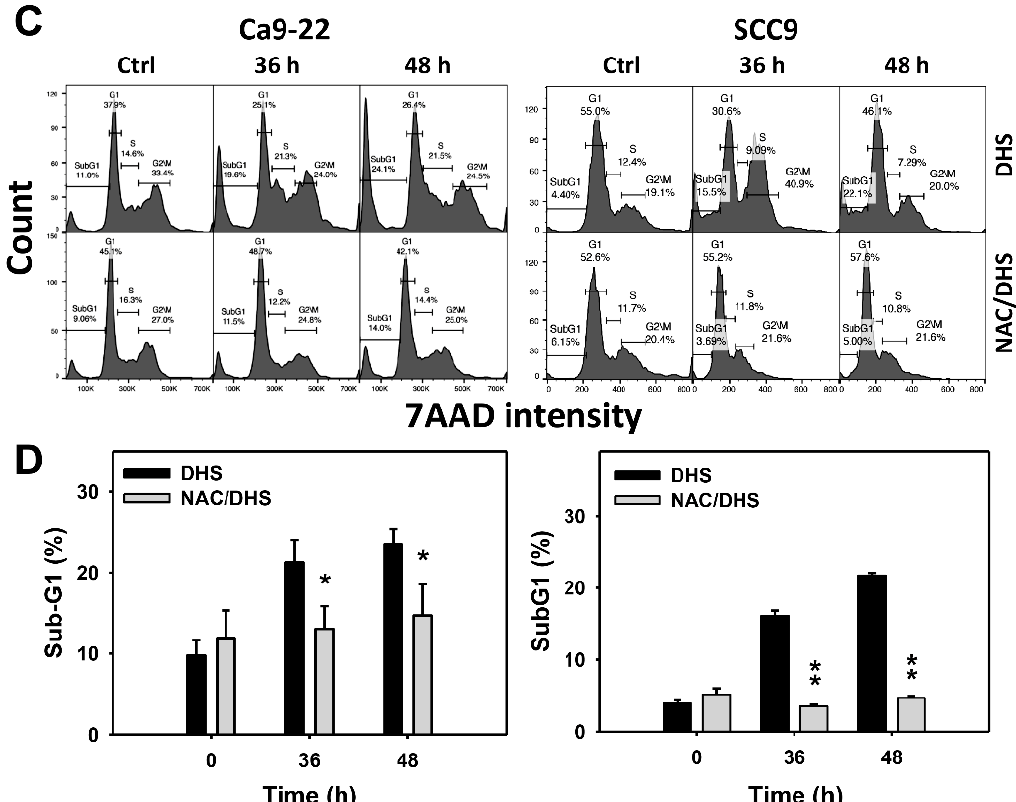
Figure 2. DHS effects on subG1 accumulation of oral cancer cells. ( A , B ) Representative cell cycle patterns of DHS-treated oral cancer cells. Cells (Ca9-22 and SCC-9) were treated with 0.4, 0.6 and 0.8 mM DHS or vehicle (containing 0.08% DMSO) for 48 h. ( C , D ) Alleviation of subG1 accumulation of DHS-treated oral cancer cells by NAC. Cells were pretreated with NAC (4 mM, 1 h) or not, and then they were treated with 0.6 mM DHS or vehicle for 0, 36 and 48 h. Data = means ± SDs ( n = 3 independent experiments). * and ** indicate significant differences between ( A , B ) DHS and control and ( C , D ) DHS and NAC/DHS ( p < 0.05 and 0.01, respectively). A positive control for subG1 accumulation of oral cancer cells is provided in Supplementary Figure S1.